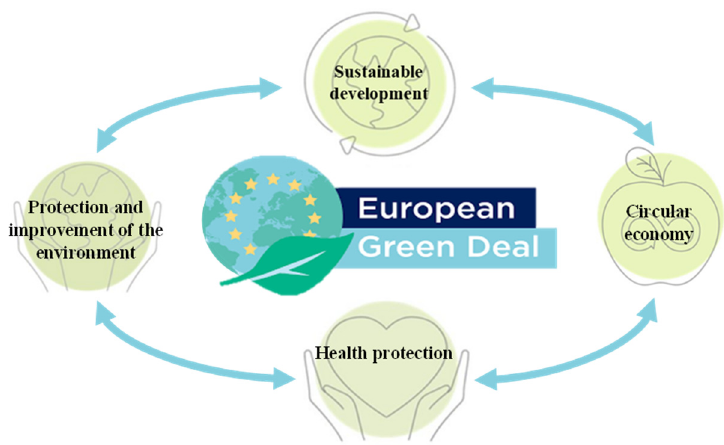
Figure 1. Graphical representation of certain fundamental issues for the European Green Deal.